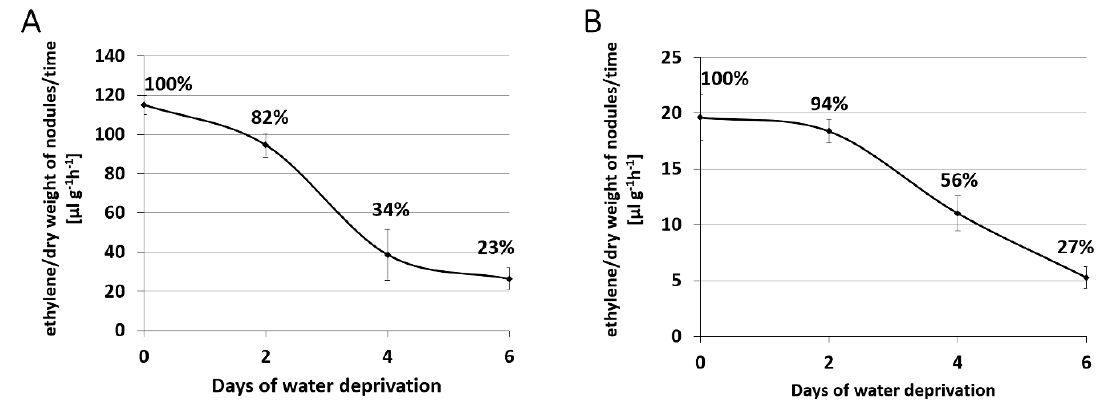
Figure 1. Nitrogenase activity in root nodules harvested from drought-treated M. truncatula ( A ) and L. japonicus ( B ), estimated using an acetylene reduction assay.